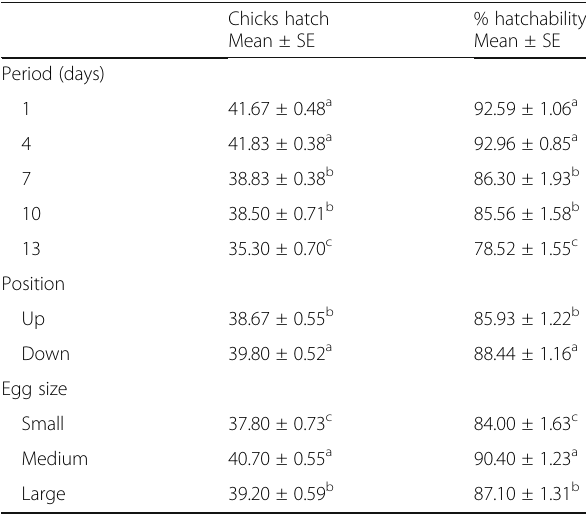
Table 2 Effects of the interaction between storage period and position, storage period and egg size, and egg size and position on chicks hatched and hatchability percentage Chicks hatch Mean ±